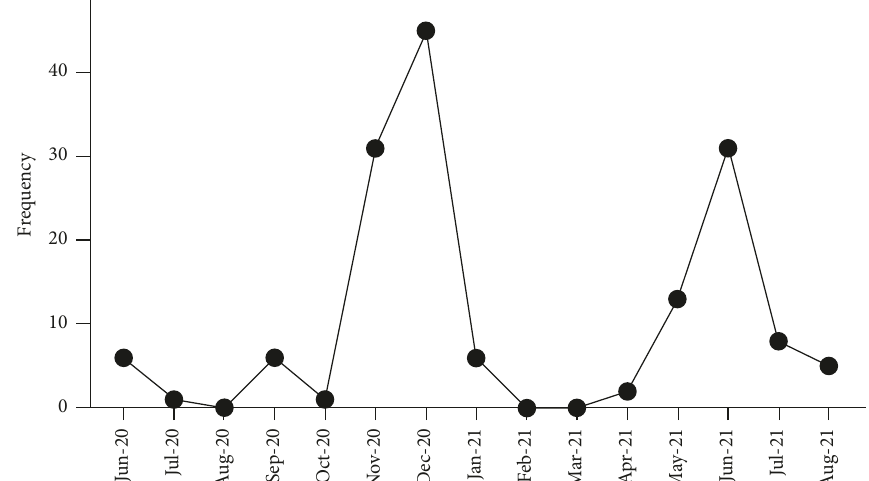
Figure 1: Trends in admission of patients with COVID-19 at case hospital.